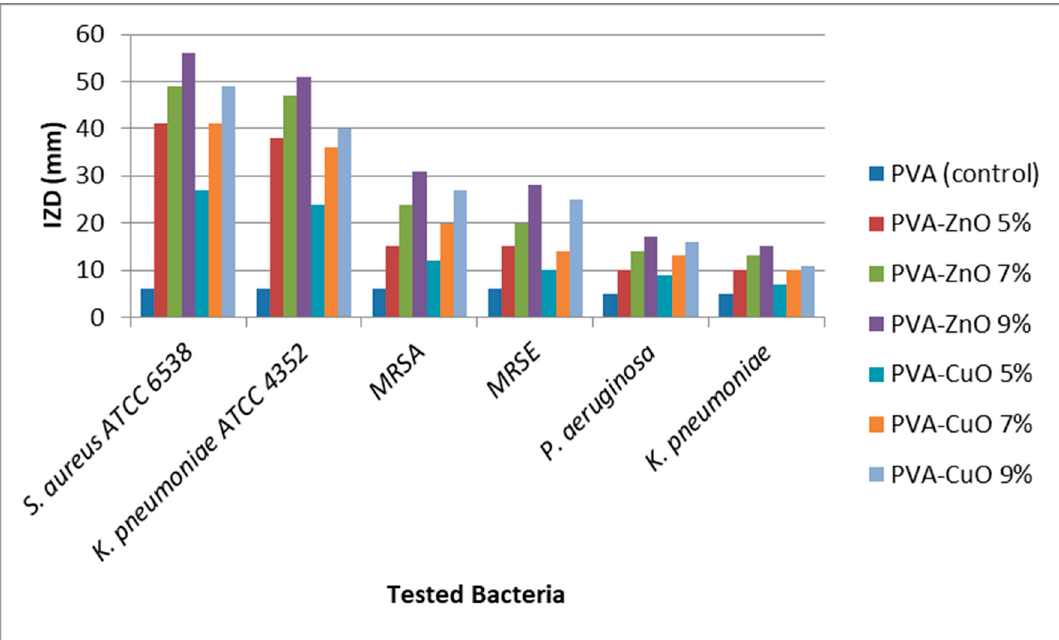
Figure 5. Inhibition zone diameter (IZD) of the tested nanofibers against ATTC and MDR